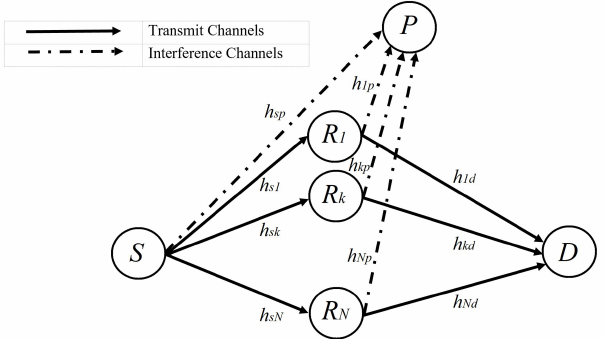
Figure 1. A cognitive underlay network with multiple AF